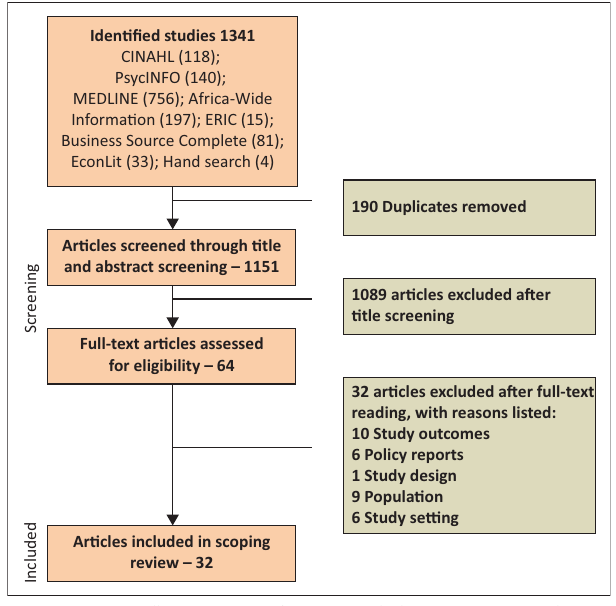
FIGURE 1: Preferred reporting items for systematic reviews and meta-analyses extension for scoping reviews.